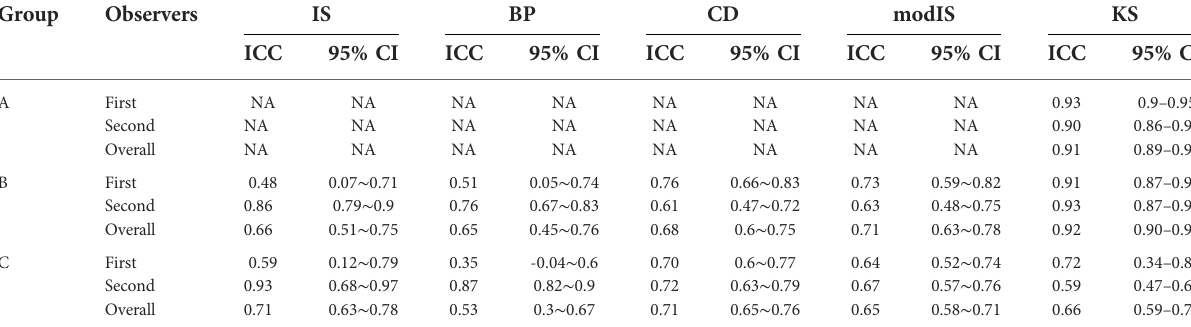
TABLE 3 Intra-observer reliability of patellar height ratios on x-ray.